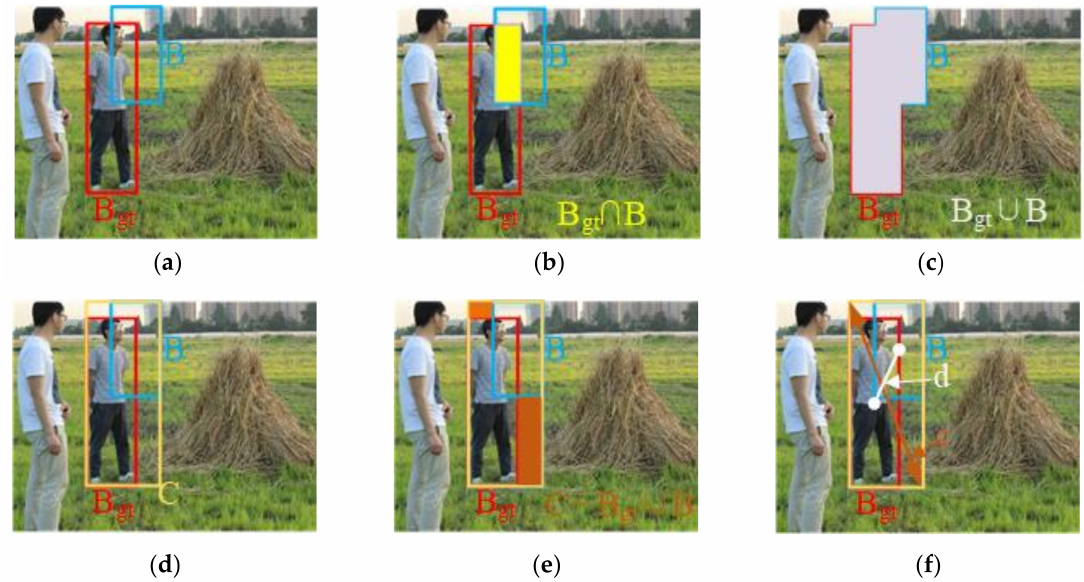
Figure 8. Visualization of the calculation process of CIoU Loss. ( a ) the ground-truth bounding box (B gt ) and the predicted bounding box (B); ( b ) the intersection of B and B gt ; ( c ) the union of B and B gt ; ( d ) the smallest bounding box C covering B and B gt ; ( e ) the union of C minus B and B gt ; ( f ) c (the diagonal length of C ) and d (the distance between the center points of B and B gt